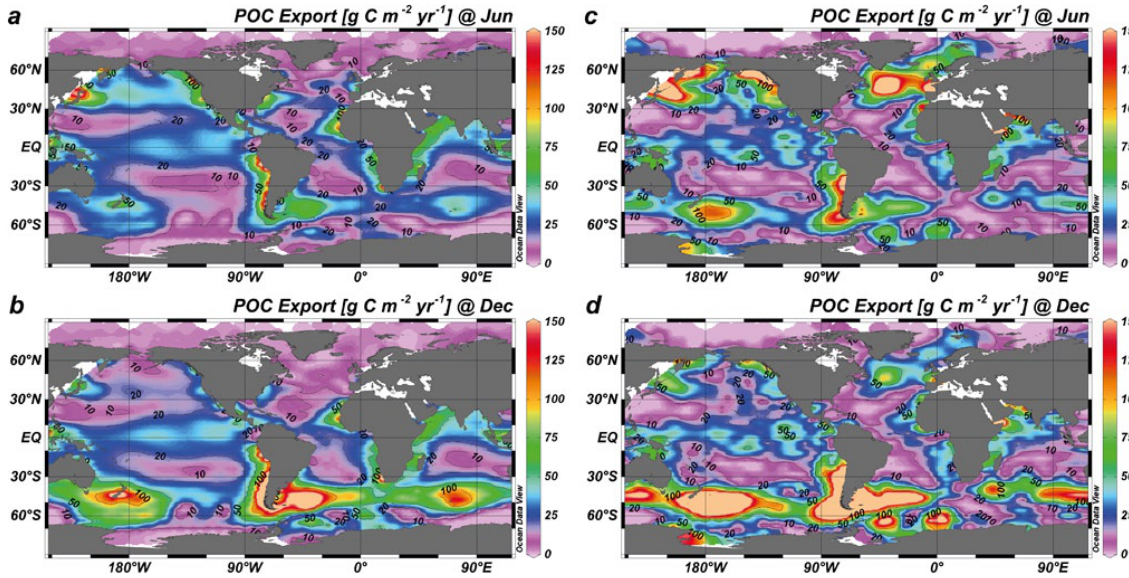
Fig. 9. Optimal POC export fields for June and December for Exp A ( a and b ) and Exp B ( c and d ). Table 5. Summary of Exp B sensitivity runs starting at different initial independent